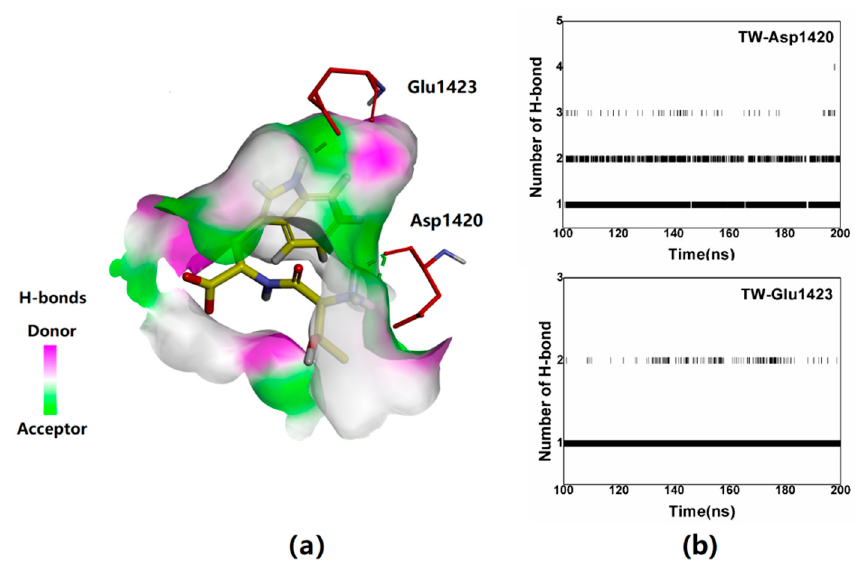
Figure 4. ( a ) Predicted detailed binding modes of MGAM-TW complex from cluster 1 and ( b ) the number of H-bonds between TW and Asp1420/Glu1423 during 100~200 ns simulation.